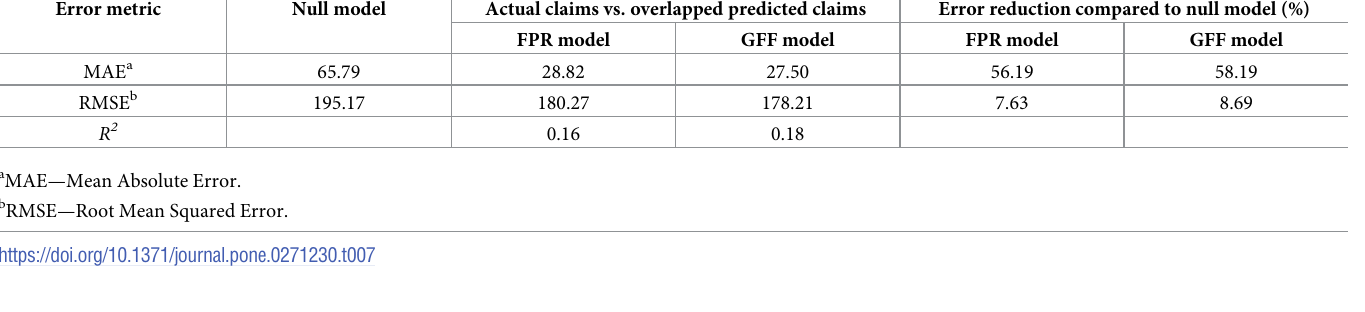
Table 7. Comparison of the total actual number of claims from actual events versus the total predicted number of claims from only predicted events with some time overlap with the actual events using the state-level analysis in 2016 at the county level. Error